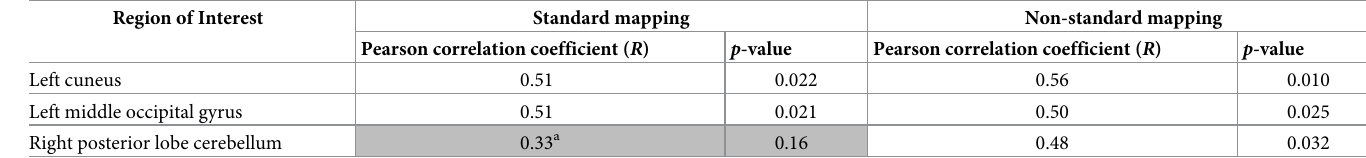
Table 3. Linear regression of the timing of mean peak beta weights versus estimated time spent playing action video games each week. Region of